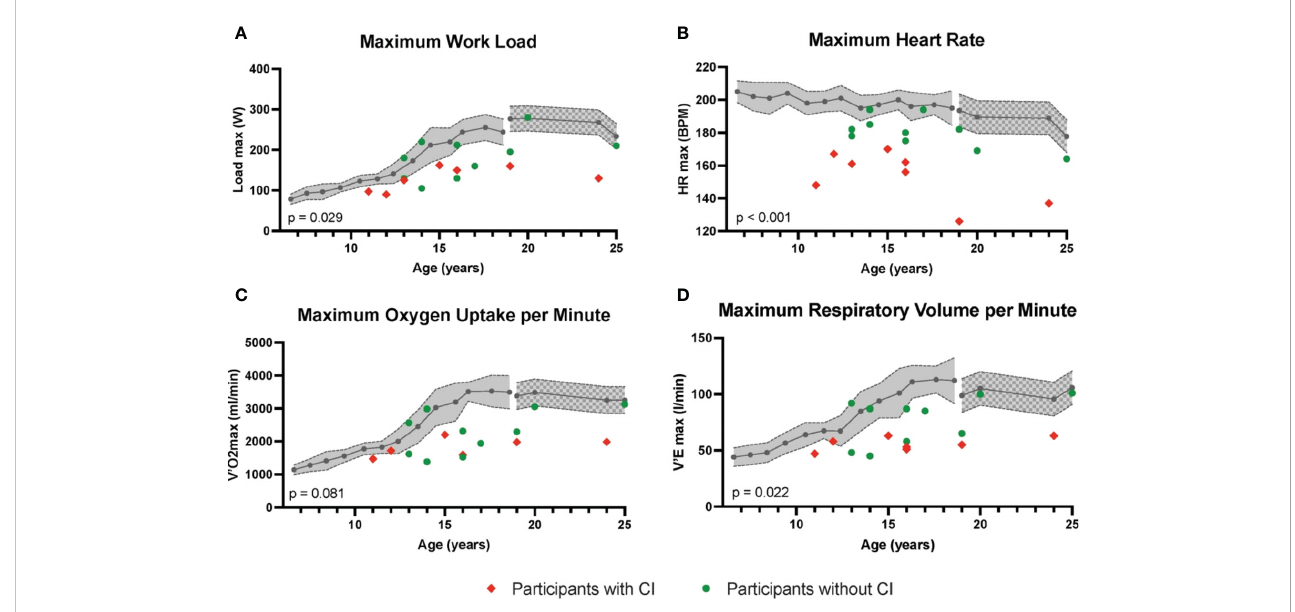
FIGURE 2 Cardiopulmonary exercise test (CPET). Results of CPET in participants with KS (red squares and green circles) expressed as (A) maximum workload achieved on the ergometer in Watt, (B) the maximum heart rate in BPM, (C) the maximum oxygen uptake per minute [ml/min] and (D) the respiratory minute volume [l/min]. The grey area indicates the age-appropriate mean and standard deviation according to the results of Klemt et al. (28) for children and adolescents aged 6 to 18 years; the gray patterned area indicates the age-appropriate mean and standard deviation according to the results of Gläser et al. for adults (30). Participants with chronotropic insuf fi ciency (CI) are shown as red squares; participants without chronotropic insuf fi ciency as green circles. HR, Heart rate; V ’ O2 max, Maximum oxygen uptake; V ’ E max, Maximum respiratory volume; CI, Chronotropic insuf fi